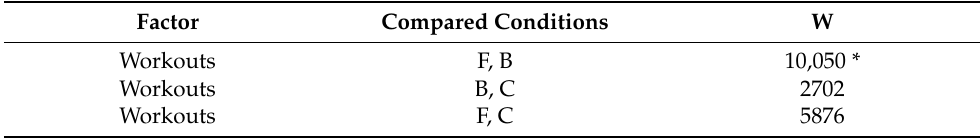
Table 13. Post-hoc Mann–Whitney tests results for workouts in Non-Beginners. Factor Compared Conditions W Workouts F, B 10,050 * Workouts B, C 2702 Workouts F, C